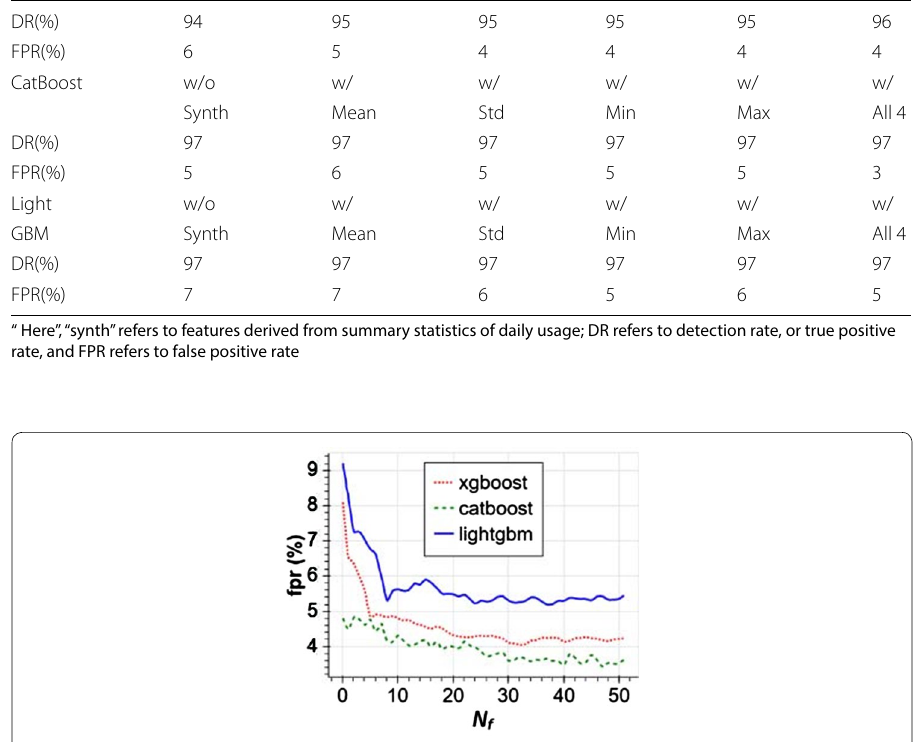
Fig. 4 From [31]; false positive rates for XGBoost, CatBoost, and LightGBM as number of features